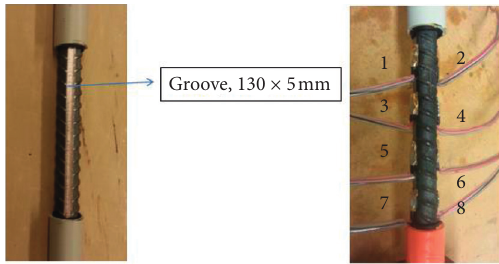
Figure 2: Groove for the gauges and the installed gauges.